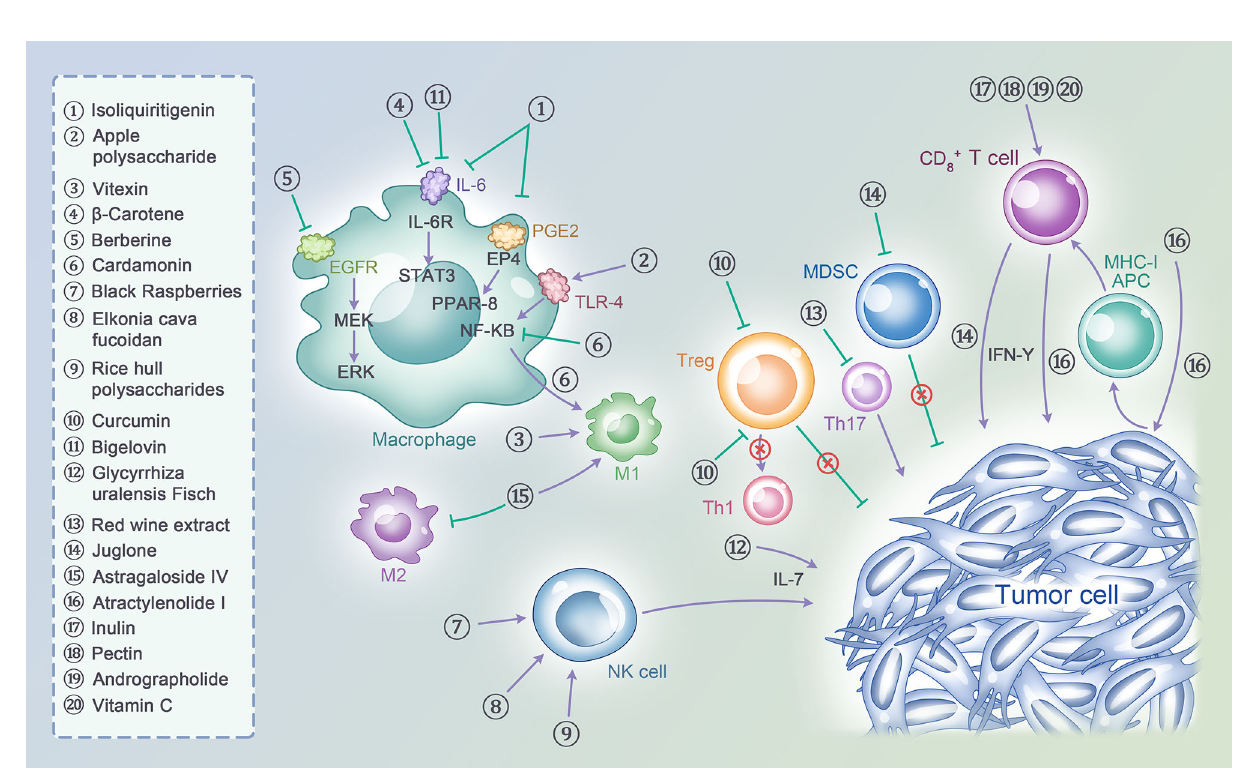
FIGURE 1 | A variety of natural products act on act on multiple cell subtypes in the tumor immune microenvironment, including T cells, NK cells, Macrophages, MDSCs, Tregs and tumor cells themselves, to exert immunomodulatory effects and thus enhance the ability of anti-tumor